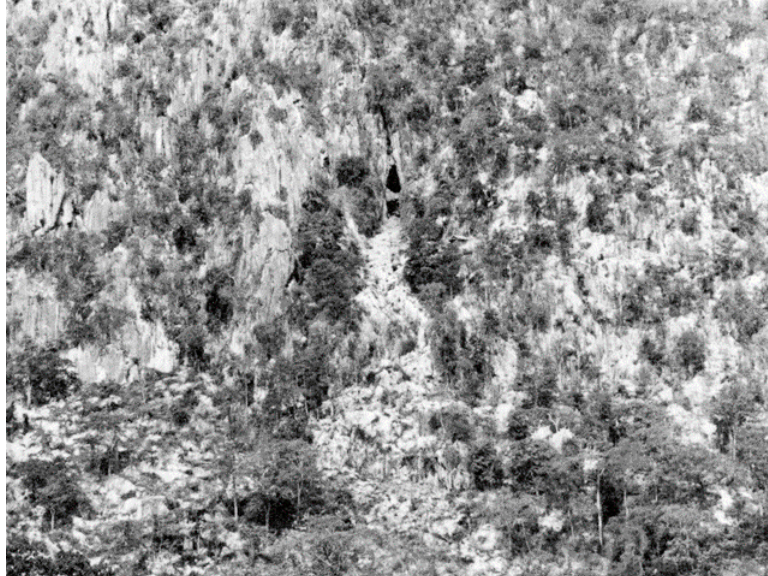
Figure 1. Kaeng Khoi cave,